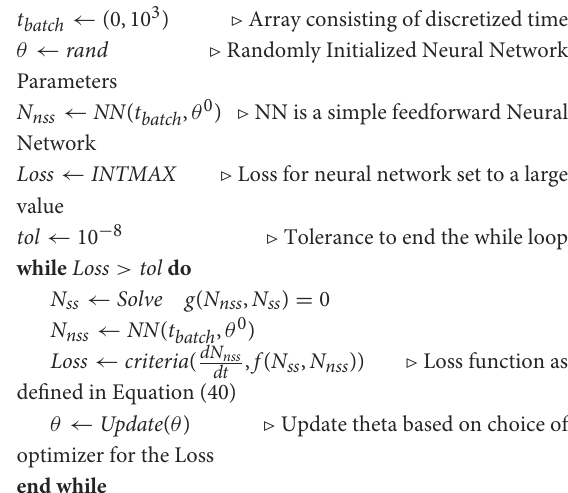
Algorithm 1 Physics Informed Neural Network with